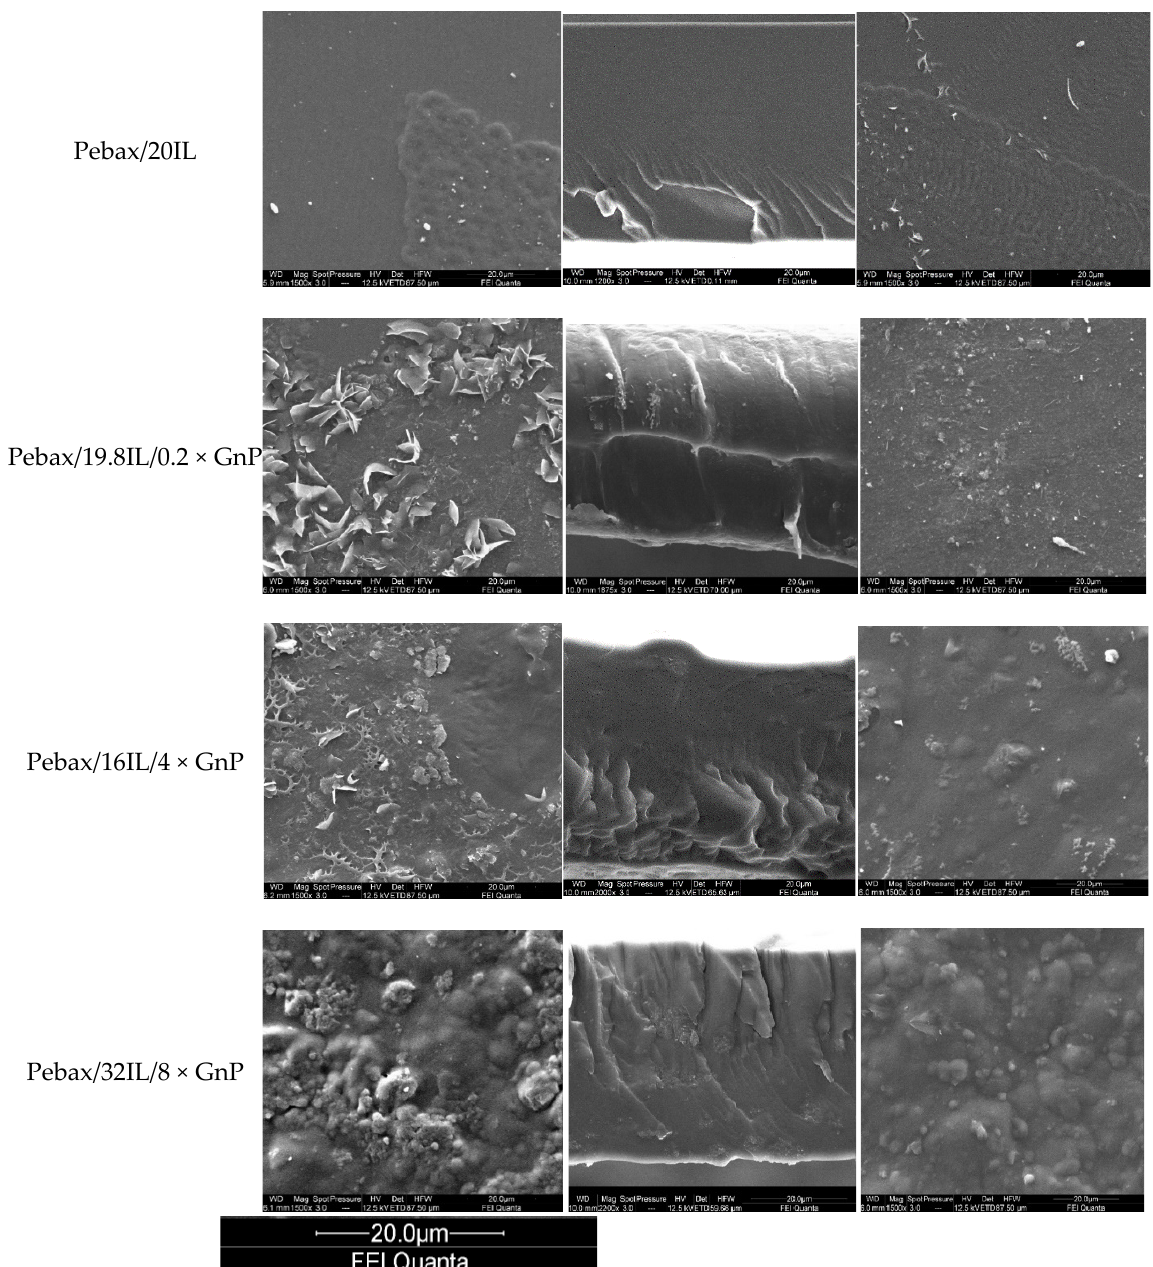
Figure 7. SEM images of Pebax; Pebax/20IL; Pebax/19.8IL/0.2 × GnP; Pebax/16IL/4 × GnP; and Pebax/32IL/8 × GnP—full names in Table 1.